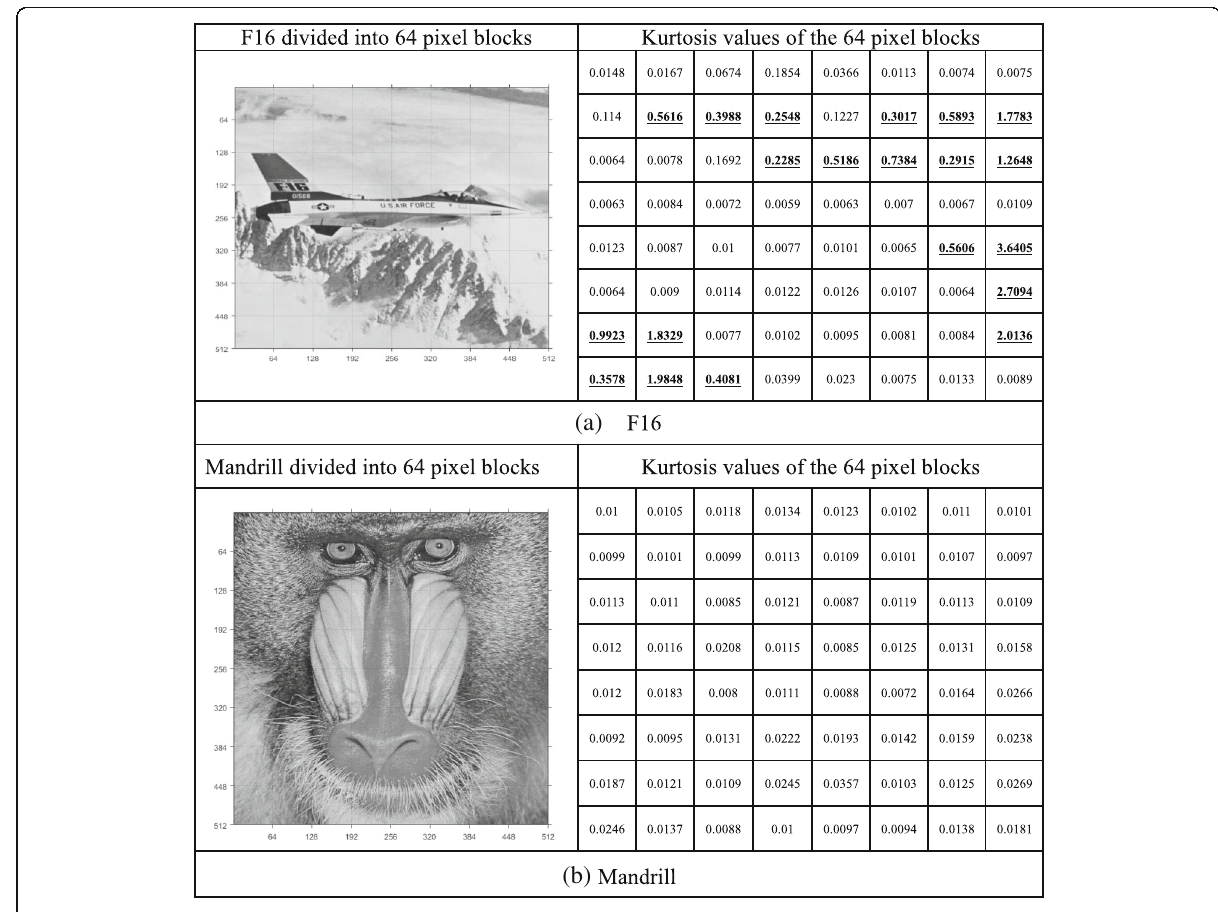
Fig. 9 Kurtosis values of the 64-pixel blocks of F16 and